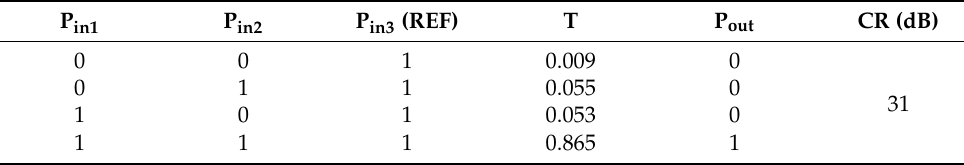
Table 2. Table 2. Simulation findings for AND (T th = 0.14). Table 2. Simulation findings for AND (T th = 0.14). Table 2. Simulation findings for AND (T th = 0.14).